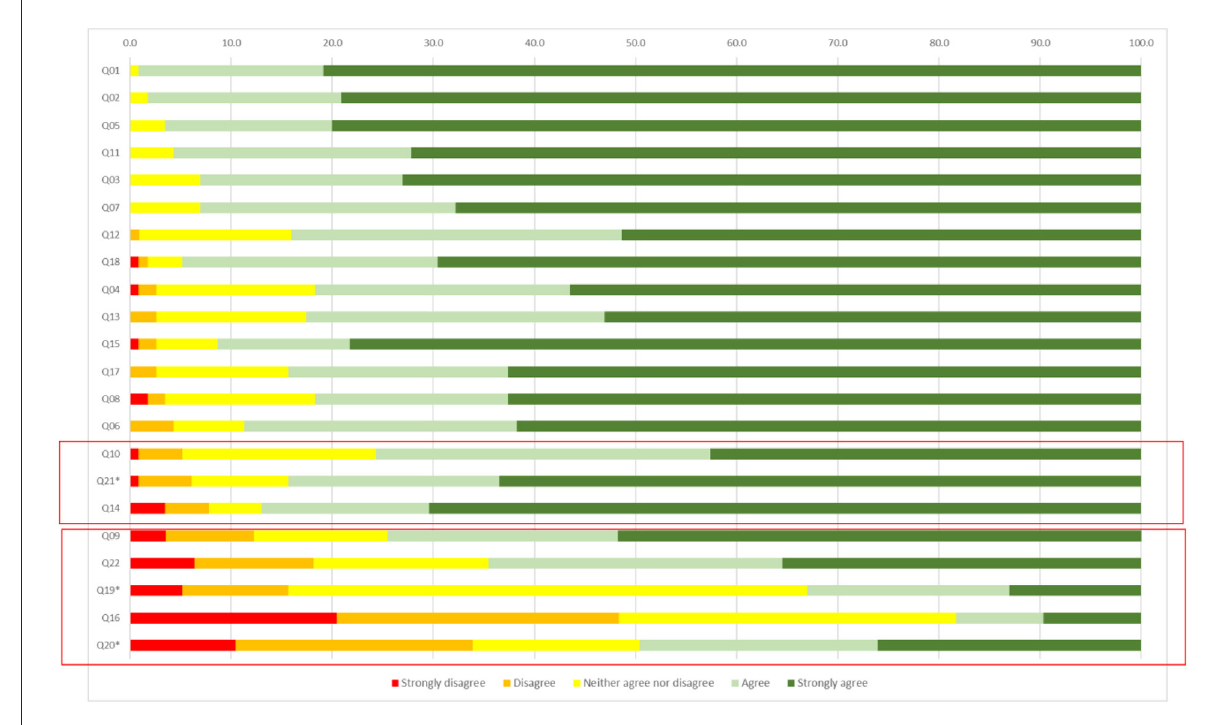
FIGURE1 Patients’ items’ response distribution at baseline. *Are negative statements so answers were inverted.